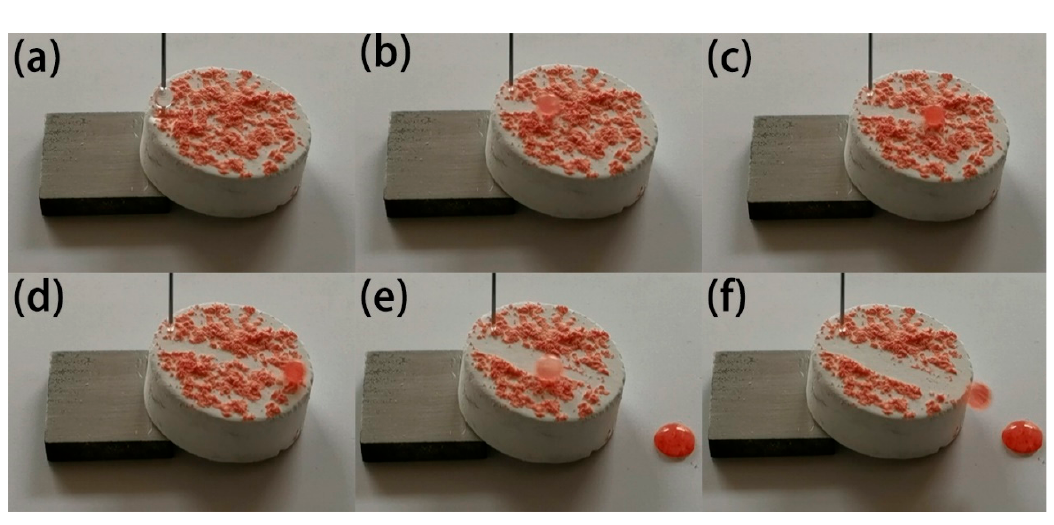
Figure 8. ( a – f ) Self-cleaning test of chalk ash.